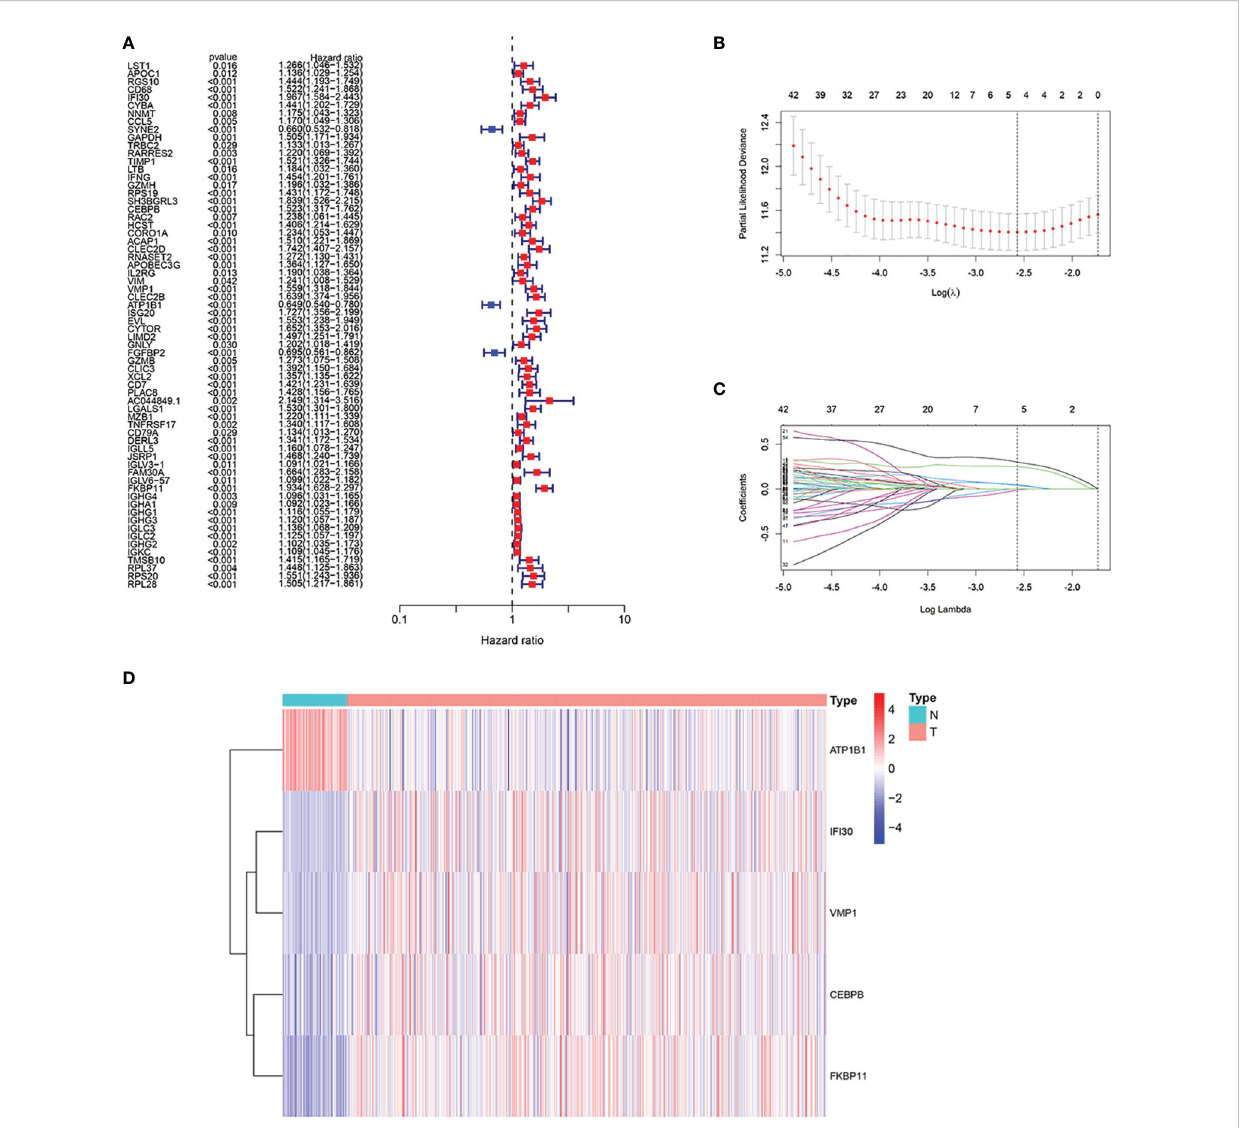
FIGURE 4 Construction of the prognostic model. (A) We succeeded in obtaining 66 genes associated with the prognosis of the patients through the univariate Cox analysis, 63 of which had a hazard ratio (HR) > 1. (B, C) 5 genes were selected to construct the prognostic model by Lasso regression. (D) Expression of 5 model genes in the transcriptome sequencing of normal and ccRCC patients.